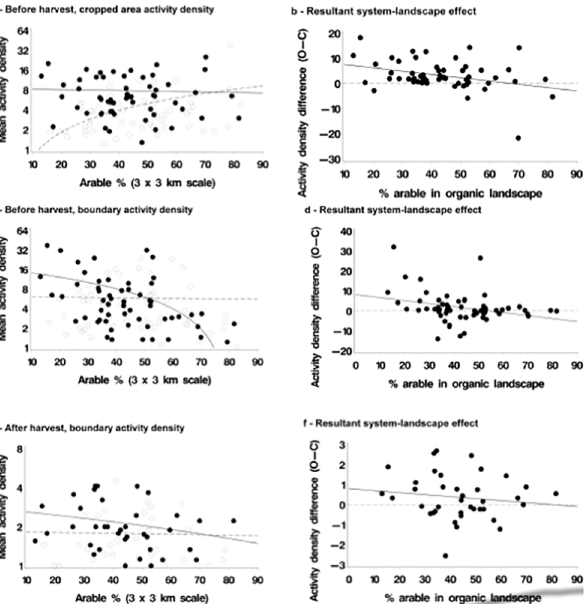
Fig 1. Effects of farming system and landscape (% arable) on activity density of hunting spiders where system effect is significant. Organic: solid lines, filled points; conventional: dotted line, open points. Plots in left hand panel: lines in plots are linear regressions plotted on log scale by system, points are farms. Plots in right hand panel: lines in plots are linear regression (solid line) and reference line (dotted at system difference = zero), points are farm pairs. Right hand panel extracts system effect from left hand panel, O-C difference on arithmetic scale.